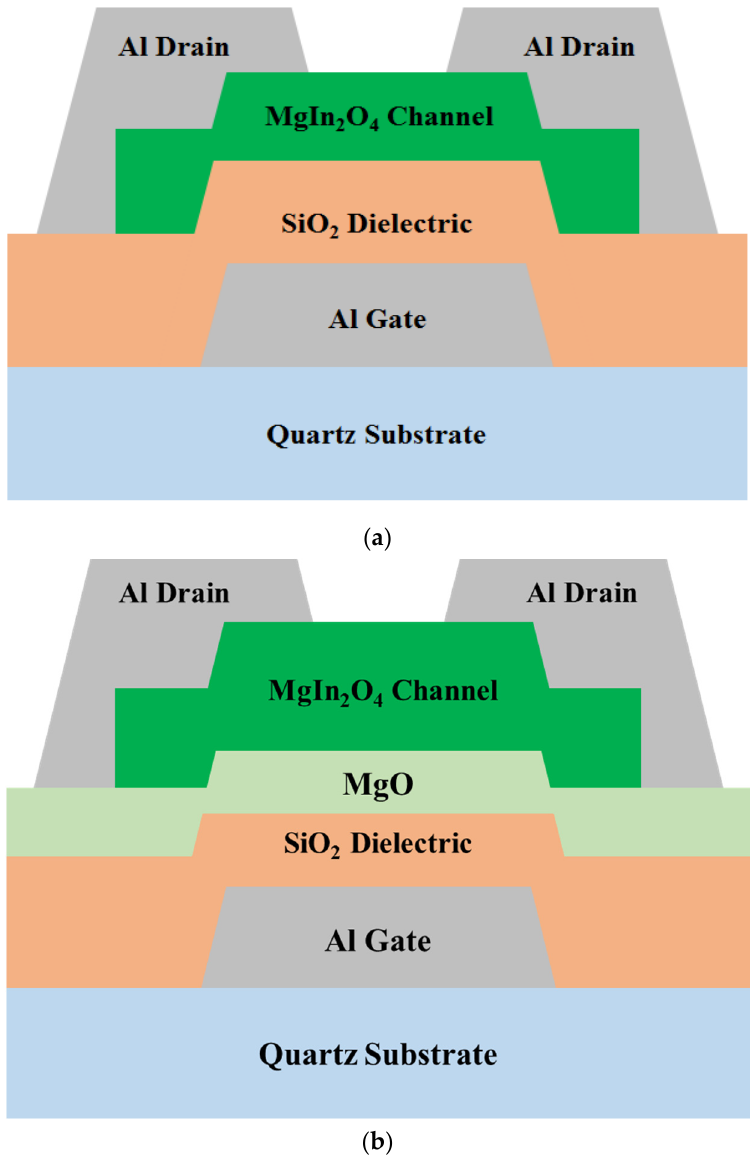
Figure 1. Schematic structure of ( a ) the MgIn 2 O 4 thin film transistor (MIO TFT) and ( b ) the MIO TFT with an MgO buffer layer.